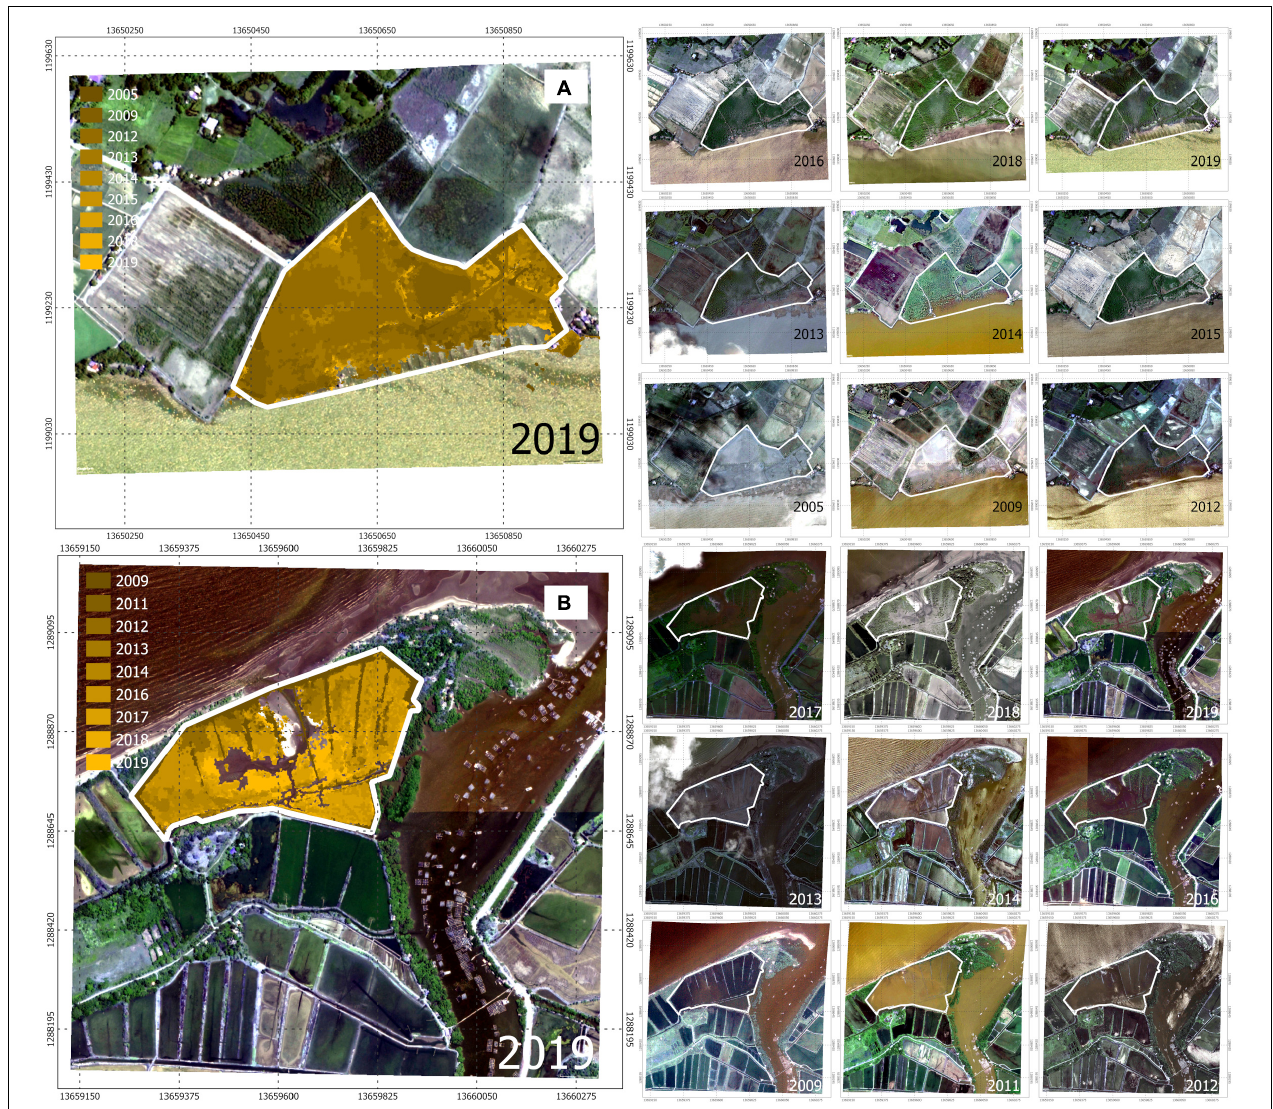
FIGURE 2 | Imagery segmentation classification of available annual Google Earth RGB imagery from abandoned pond dike breaching at (A) the Leganes Katunggan, Iloilo study site over 2005–2019 [natural regeneration (NR) to 2009, followed by assisted natural regeneration with planting (ANR) from 2009; see Figures 3H,I ], and (B) the Roxas City, Capiz study site (NR over 2009–2019; see Figure 3F ). See Supplementary Figures 1A–F for all remaining NR abandoned pond